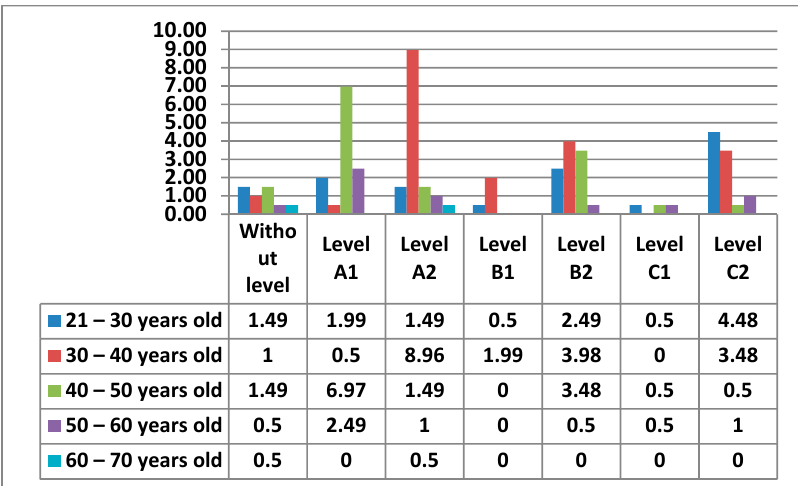
Figure 16. Percentage of women’s digital competence by age in area 2.